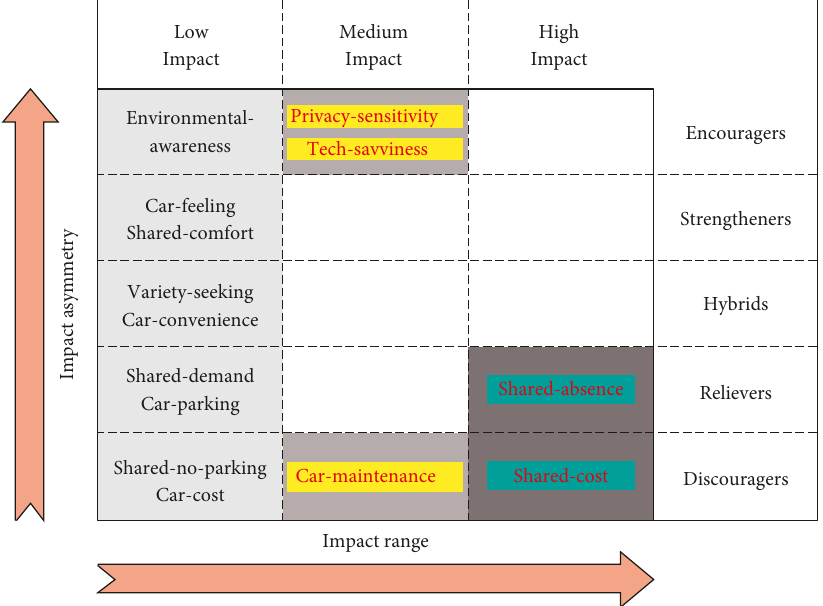
Figure 7: The comprehensive importance hierarchy of the pre-COVID-19 car purchase intention.